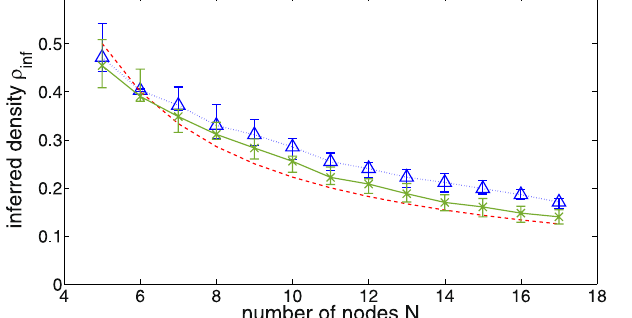
Figure 2. Average inferred link densities ρ inf as a function of network size, if our maximum entropy method is applied using unthresholded estimated mutual informations. The actual network densities are ρ = 0.1 (blue triangles and dotted line), and ρ = 1 (green Xs and solid line). The red dashed curve is the density of a network in which every node interacts with two neighbors on average, and given for comparison. The inferred density is calculated as the number of inferred links over the number of possible links, ( ) N 100 realizations of natural frequencies and coupling matrices with given density ρ . The error bars indicate the 25% and 75% quantiles.